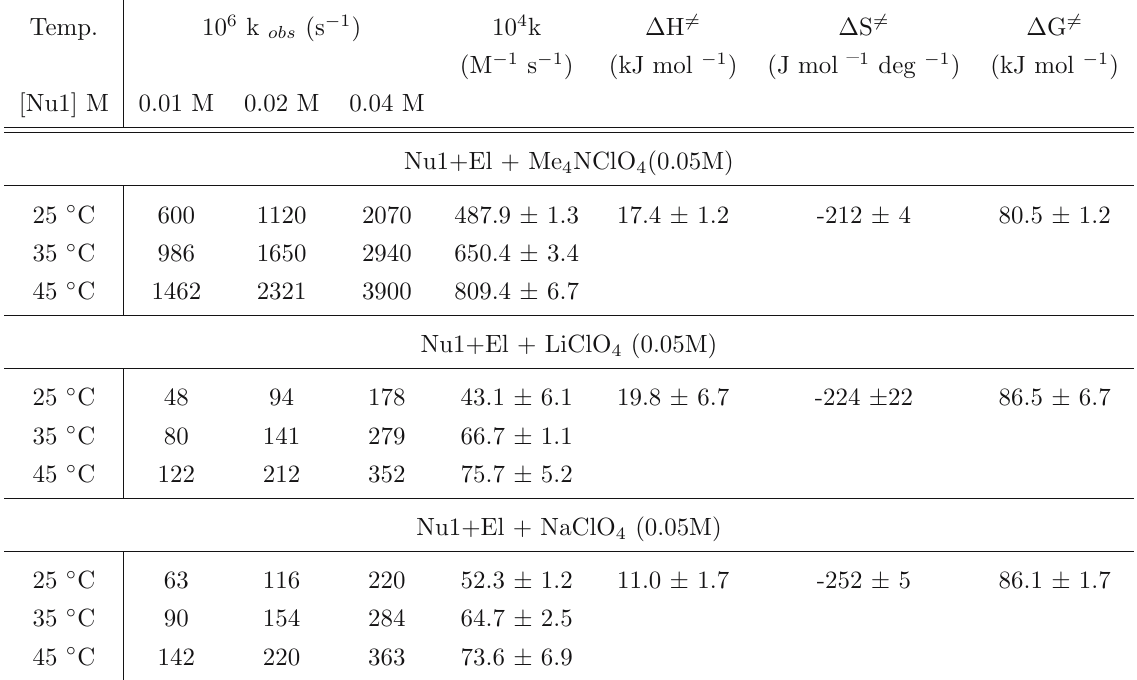
Table 4 Rate constants (k) and activation parameters ( ± standard deviation) of the reaction between Nu1 and El in acetonitrile. Temp.